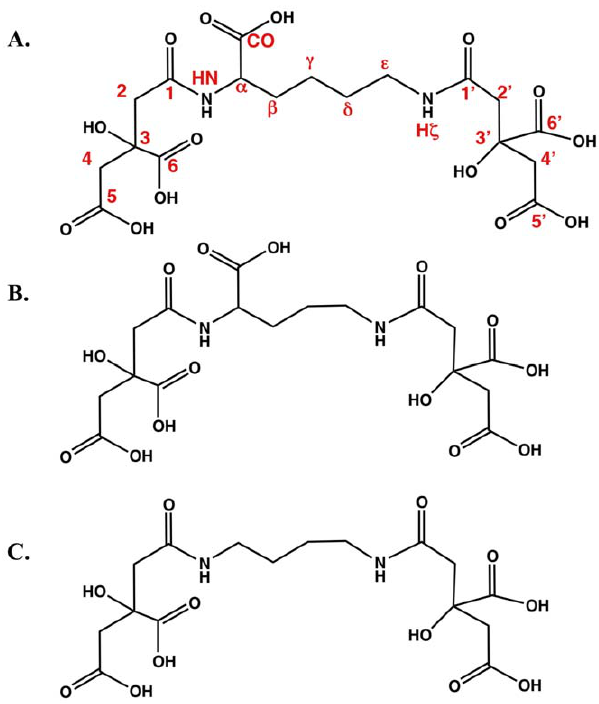
Figure 5. Comparison of structures of corynebactin, staphylo- ferrin A, and rhizoferrin. A. Structure of corynebactin determined by NMR spectroscopy. B. The published structure of staphyloferrin. C. The published structure of rhizoferrin.